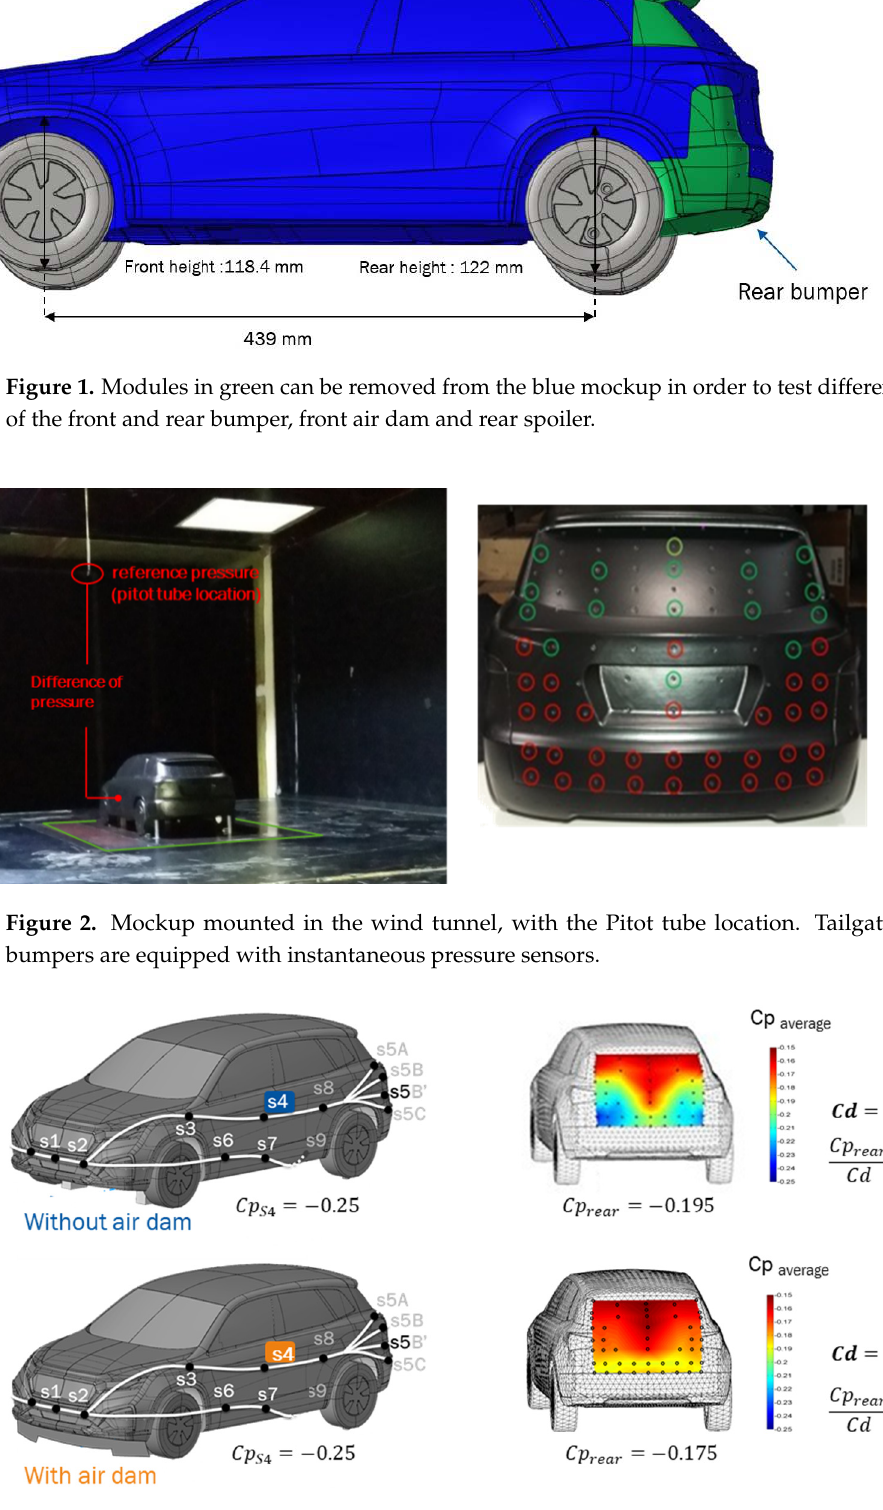
Figure 1. Modules in green can be removed from the blue mockup in order to test different variants of the front and rear bumper, front air dam and rear spoiler.